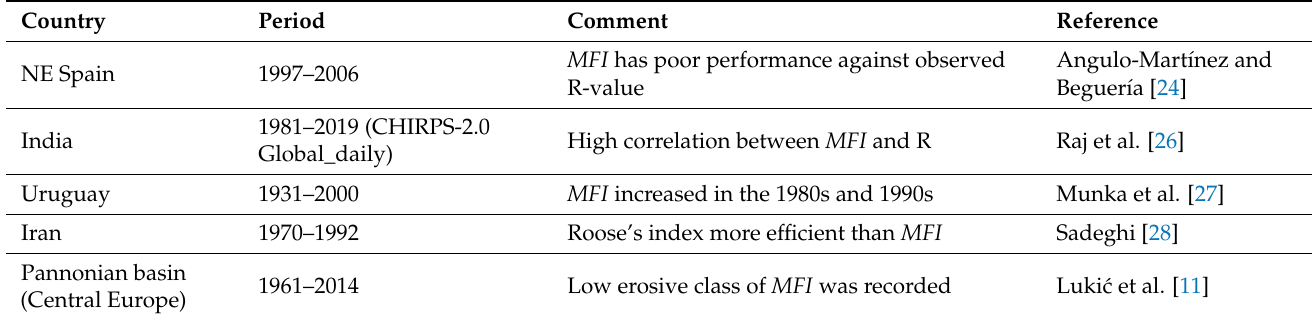
Table 1. Some examples of implementation of MFI in different parts of the